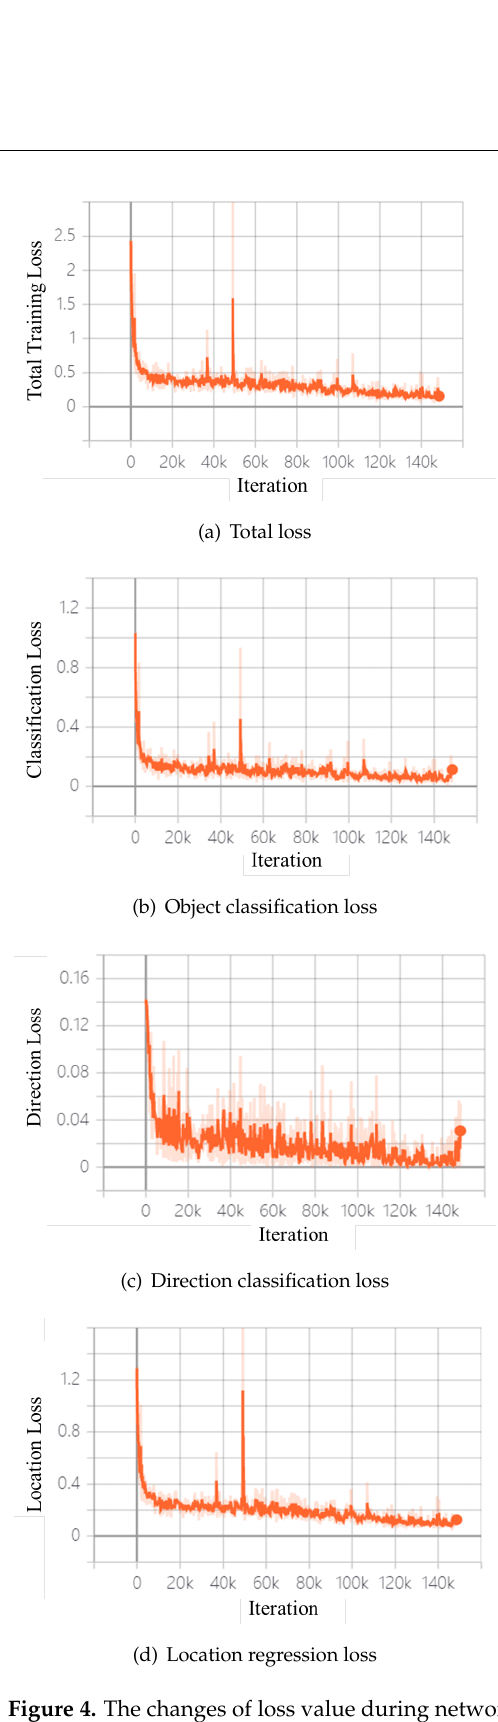
Figure 4. The changes of loss value during network